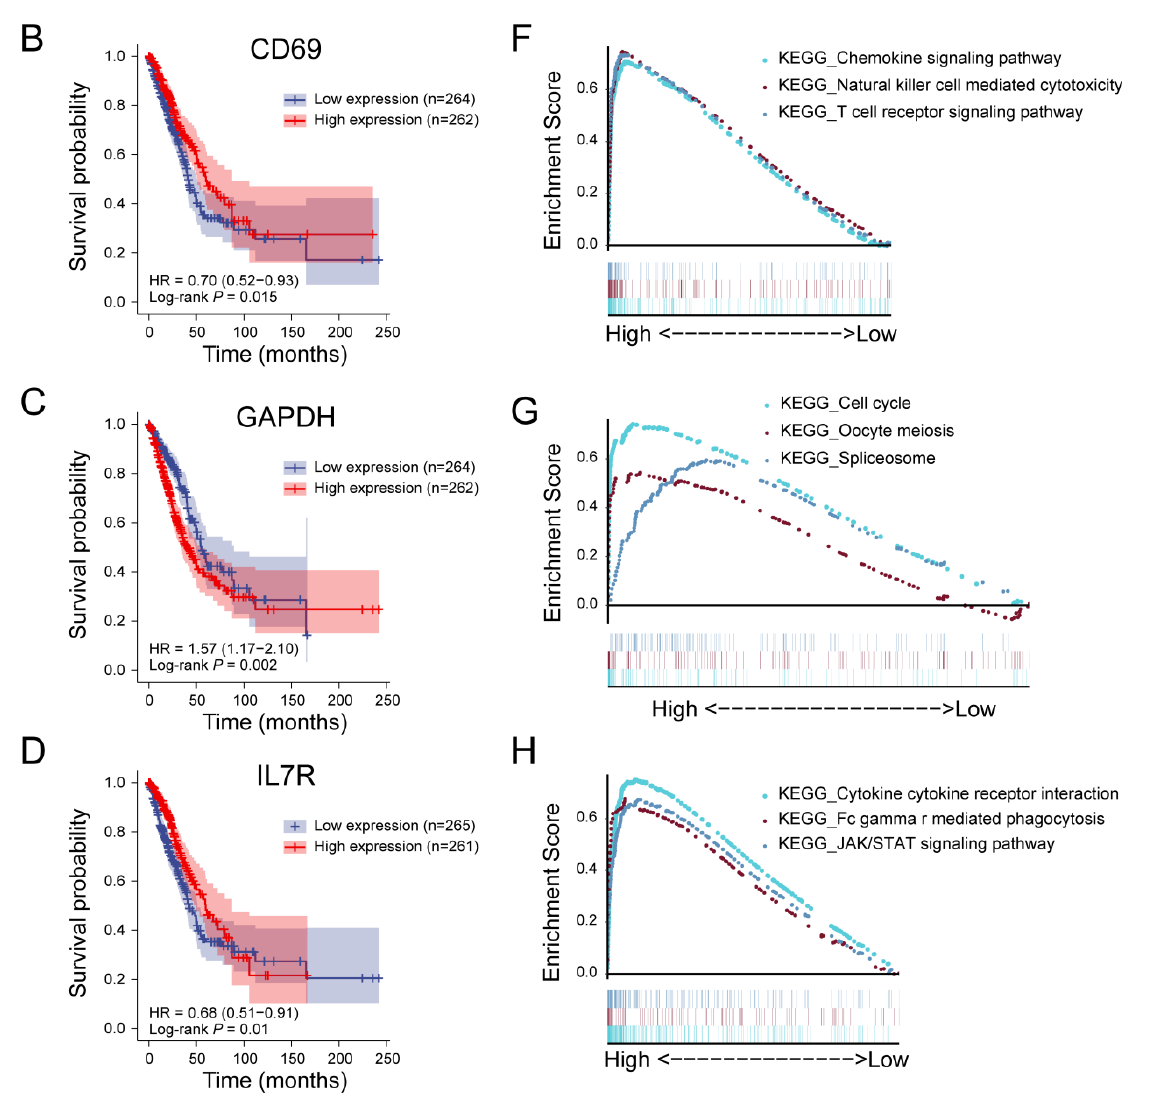
Figure 4. Prognostic analysis and single-gene GSEA analysis of hub genes. ( A ) Prognostic analysis of AGER. The higher the expression of AGER, the longer the OS of LUAD patients. ( B ) Single-gene GSEA analysis of the AGER. ( C ) Prognostic analysis of CD69. The higher the expression of CD69, the longer the OS of LUAD patients. ( D ) Single-gene GSEA analysis of the CD69. ( E ) Prognostic analysis of GAPDH. The higher the expression of GAPDH, the shorter the OS of LUAD patients. ( F ) Single-gene GSEA analysis of the GAPDH. ( G ) Prognostic analysis of IL7R. Before about 90 months, the higher the expression of IL7R, the longer the OS of LUAD patients. ( H ) Single-gene GSEA analysis of the